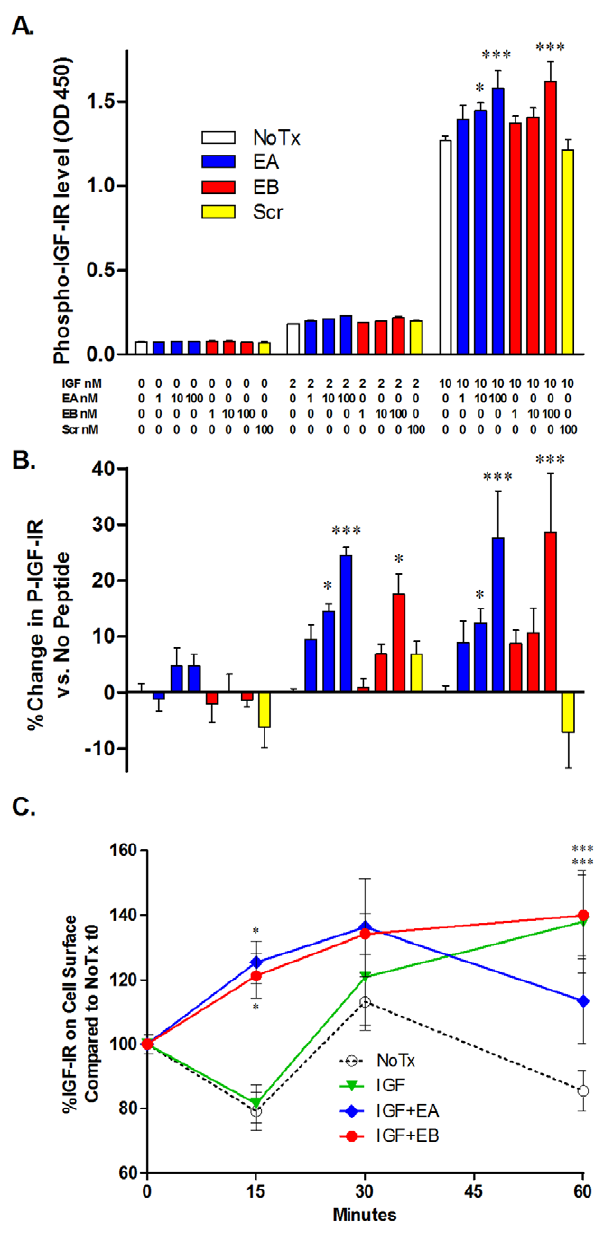
Figure 4. E-peptides augment IGF-IR activation and cell surface localization. A . P6 cells overexpressing IGF-IR were treated with synthetic E-peptides with and without recombinant IGF-I for 15 min- utes, and cell lysates were utilized for KIRA assays. Level of absorbance indicates the extent of IGF-IR phosphorylation. Bars represent means 6 s.e.m. of N=6 wells. B . OD 450 from A were compared to No Peptide for each IGF-I concentration, and the % change is graphed. C . P6 cells were treated as in A for a localization assay for times indicated, and biotin labeled before lysis. The optimal concentrations of E-peptides and IGF-I from the A were used (E-peptides 100 nM, IGF-I 10 nM). Surface IGF-IR was normalized to Total IGF-IR and compared to NoTx at t0 to get % IGF-IR on cell surface. Bars represent means 6 s.e.m. of N=6 wells. Samples were compared to no peptide (A and B,*), NoTx (C,*) or IGF-I (C, { ) via 2-way ANOVA followed by a Bonferroni post-test. * or { , p , 0.05; ***, p , 0.001.